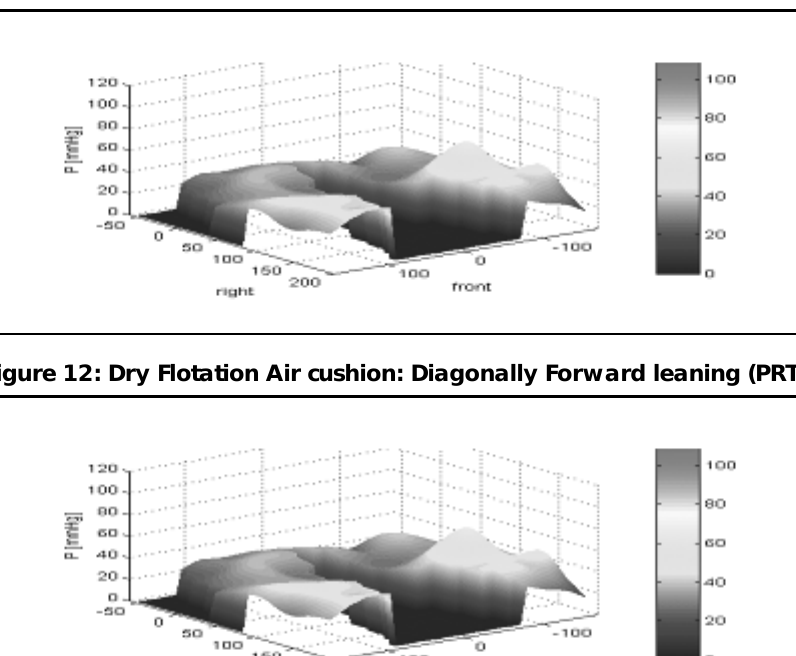
Figure 11: Dry Flotation Air cushion: Forward leaning (PRT1).